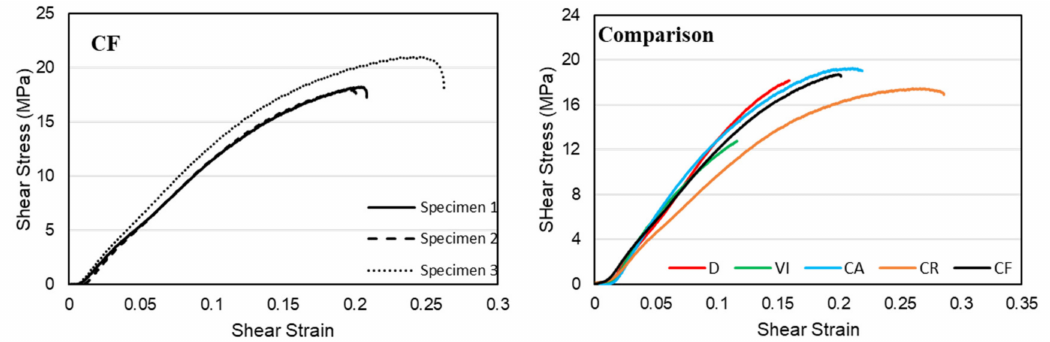
Figure 12. Experimental shear-stress-strain curves of functionally gradient lattice structures. The energy absorption of each structure is calculated by taking the area under the average shear-stress-strain curves. The energy absorbed up to the fracture point of the specimens, toughness, is calculated by approximating the stress-strain curves using the best polynomial curve and integrating the function with the range of the lowest and highest value of strain. Figure 13 shows energy absorption plots based on the area under the shear-stress-strain curves of each lattice structure. The figure below shows that the CR structure has the highest energy absorption value of 3.26 J/mm 3 due to its high angular twist values. It is followed by the CA, CF, D, and VI structures with energy absorption values of 2.63, 2.20, 1.51, and 0.77 J/mm 3 , respectively. The circular patterning of the three structures, CR, CA, and CF, gave them the advantage to withstand more angular twist over the regularly patterned unit cells.